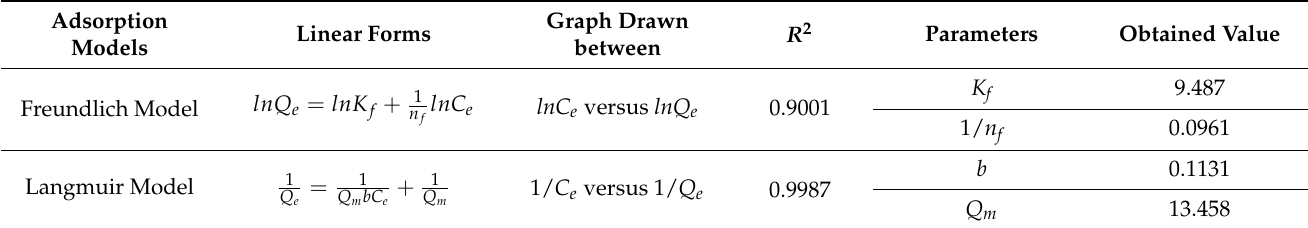
Table 2. Freundlich and Langmuir adsorption isotherm data.